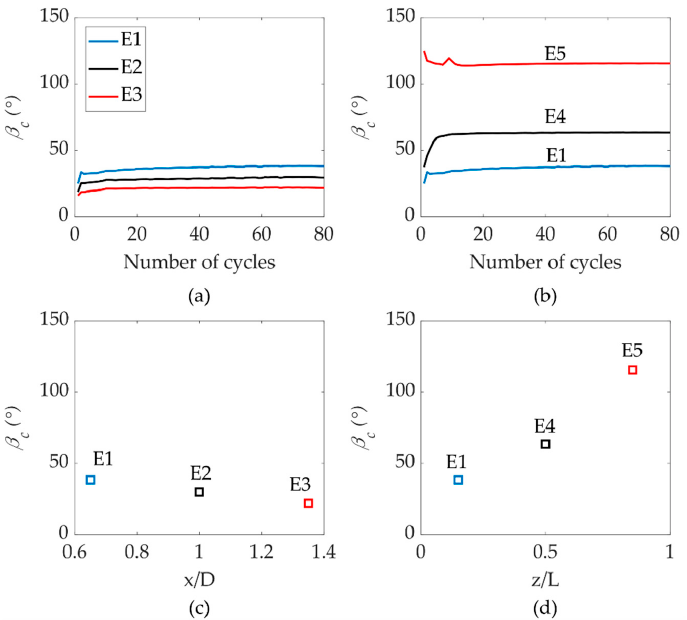
Figure 7. ( a ) Inclination β c versus no. of cycles for varying distances; ( b ) inclination β c versus no. of cycles for varying depths; ( c ) relationship between inclination β c of last stress cycle and distances; ( d ) relationship between inclination β c of last stress cycle and depths.